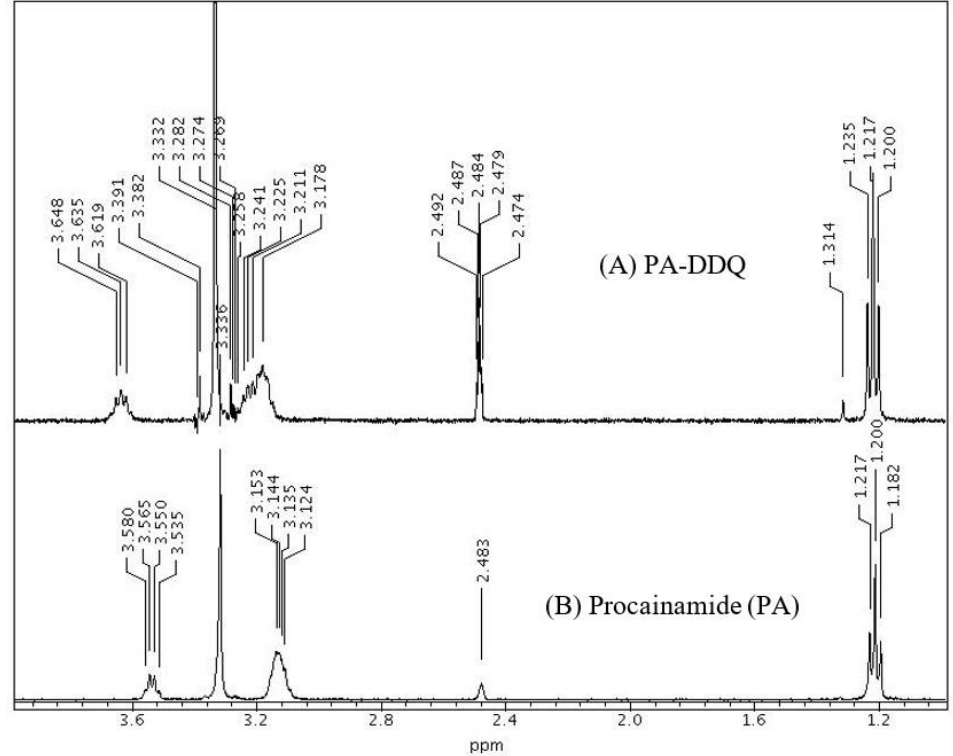
Figure 10. Comparison of proton-NMR ( 1 H-NMR) spectra of PA and PA-DDQ complex. ( A ) Aliphatic region of PA-DDQ complex; ( B ) aliphatic region of PA.